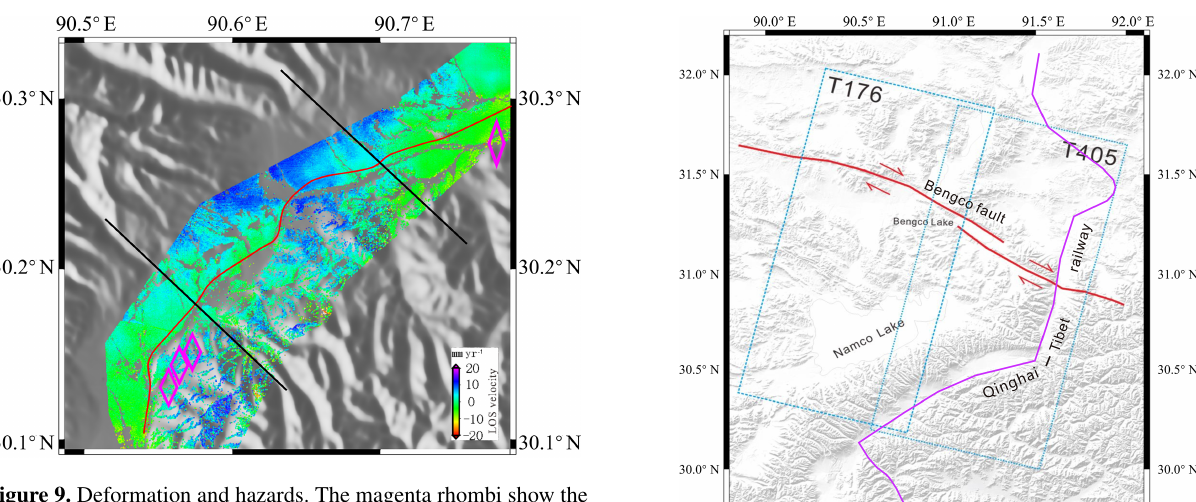
Figure 9. Deformation and hazards. The magenta rhombi show the geological hazard points.